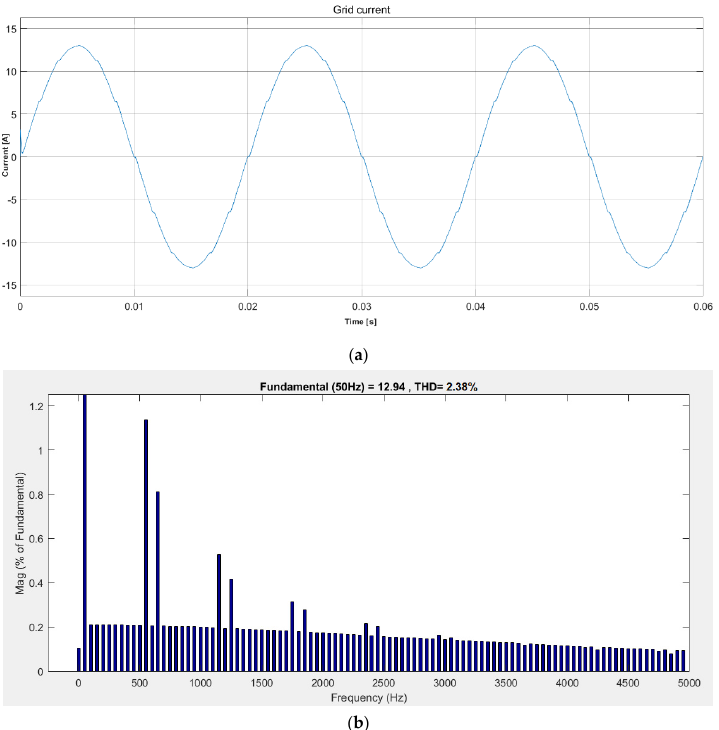
Figure 16. Grid current ( i L1 ) drawn by the rectifier with CM current modulator (based on an ideal current source) and CM 2 supporting system: ( a ) waveform, ( b ) spectral analysis.